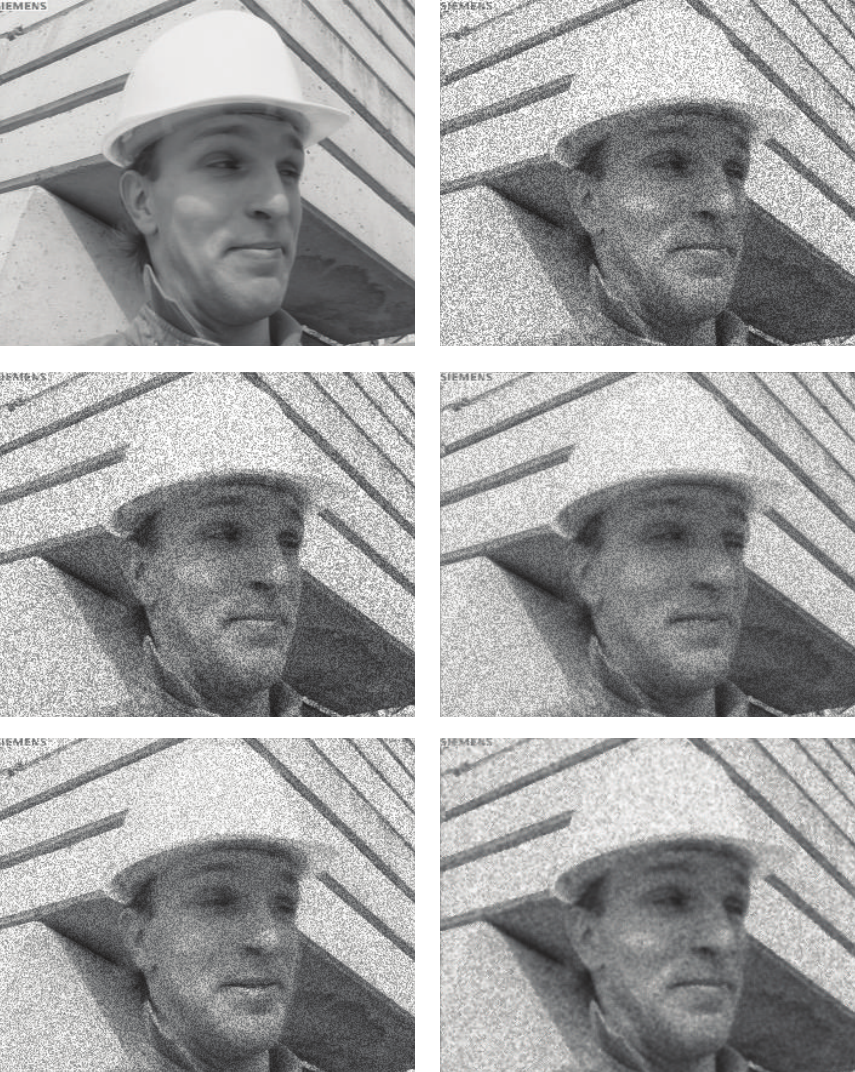
Figure 6: Visual comparison of different algorithms for frame 5 of Foreman sequence. From left to right and from top to bottom: original frame, noisy frame (noise variance = 0.04 ), result of [26] algorithm, result of [27] algorithm, result of [28] algorithm, and result of the proposed algorithm.